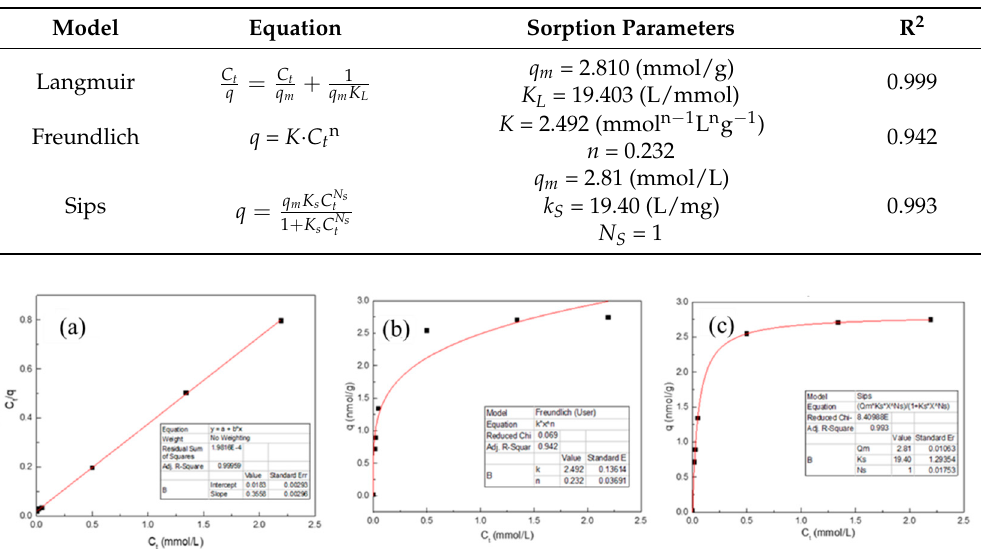
Figure 8. Isotherm adsorption fitting model of Fe(III) in presence of HAP ( a ) Langmuir ( b ), Freundlich and ( c ) Sips. Table 2. Correlations coefficients and sorption parameters obtained using Langmuir, Sips and Freundlich models.